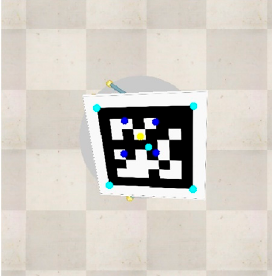
and of the sensor unit principle point (yellow).